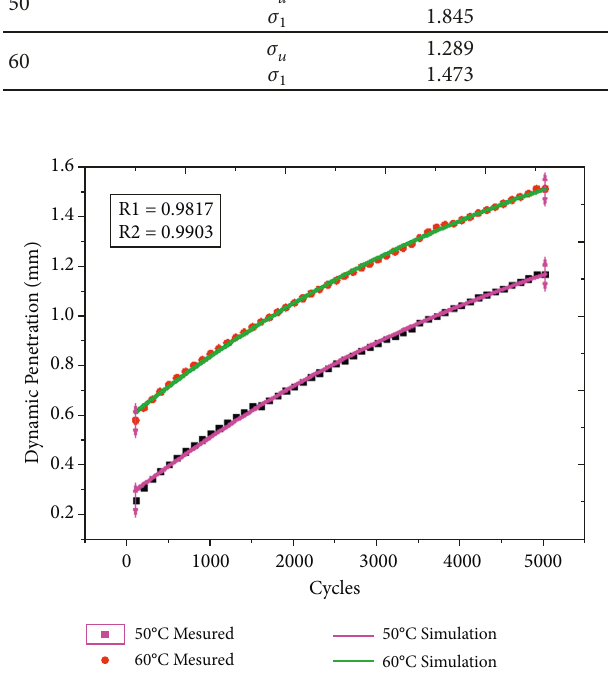
Figure 4: Measured the strain and model fit